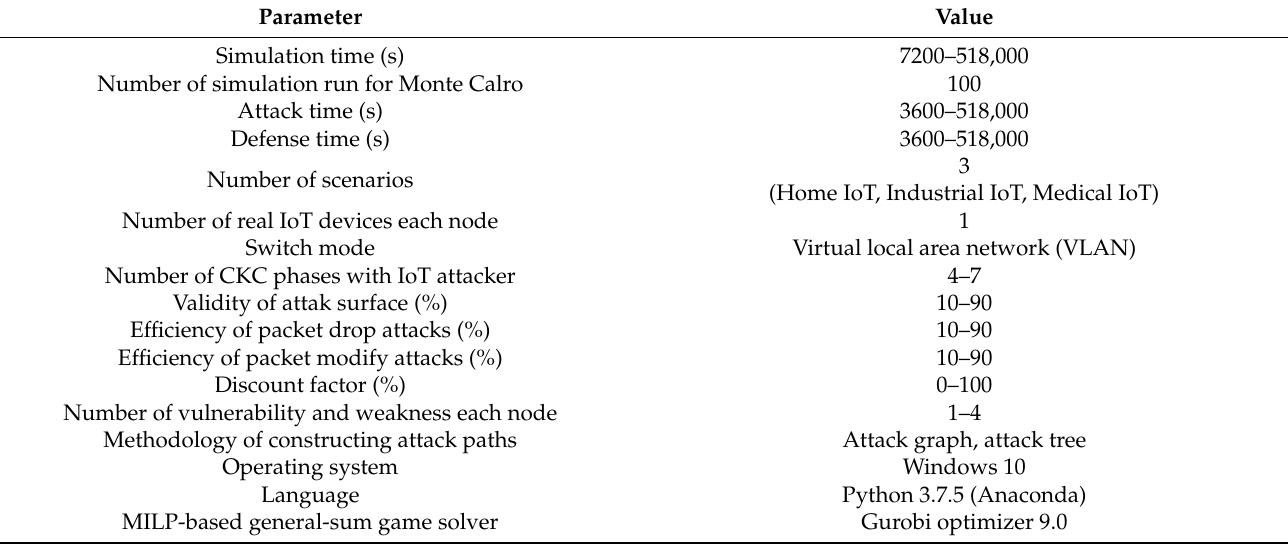
Table A5. The major decision strategy arguments with MTD and decoy in IoDM-based